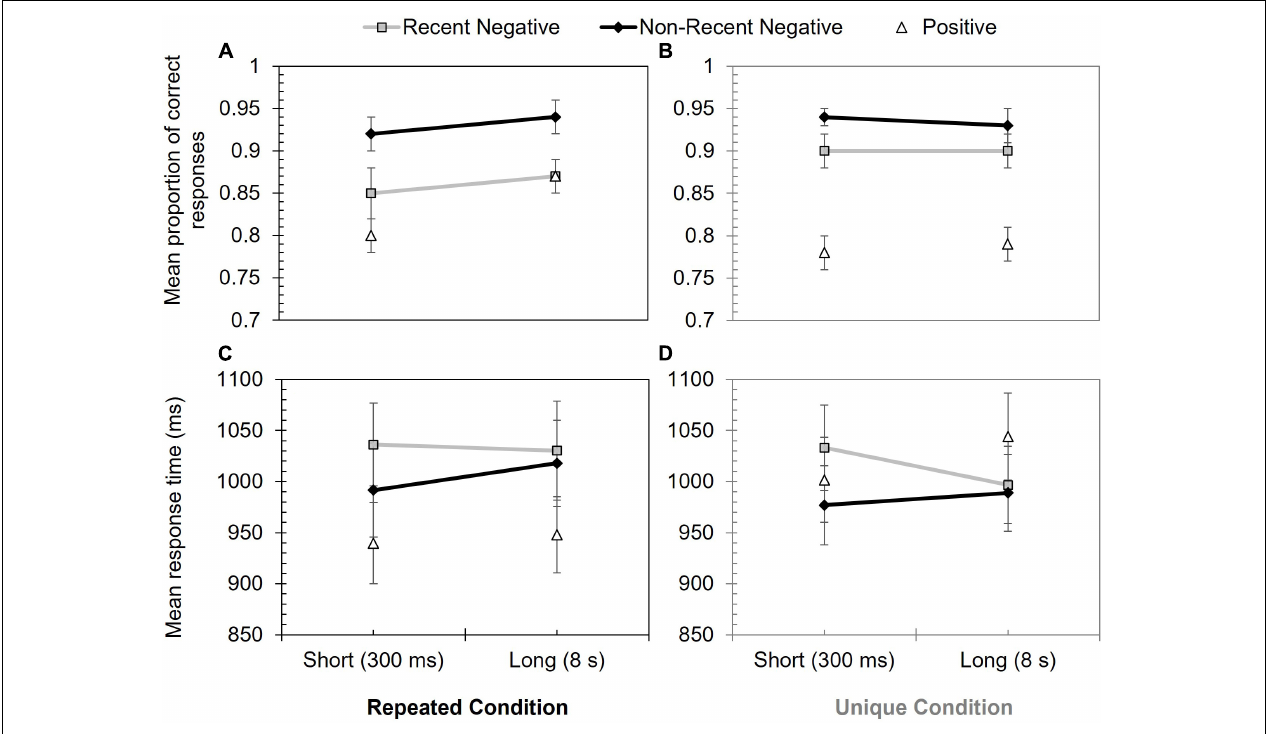
FIGURE 3 | Performance in Experiment 2 according to probe type, inter-trial interval, and stimulus novelty condition. Panels (A,B) show mean proportion of correct responses for repeated and unique conditions, respectively. Panels (C,D) show mean response time (ms) for repeated and unique conditions, respectively. Error bars show +/–1